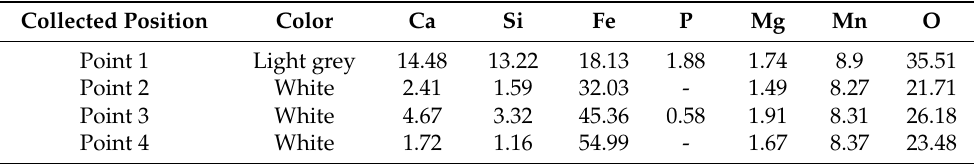
Table 7. EDS analysis results (wt.%) of dephosphorization slag in Heat 4 corresponding to Figure 11.